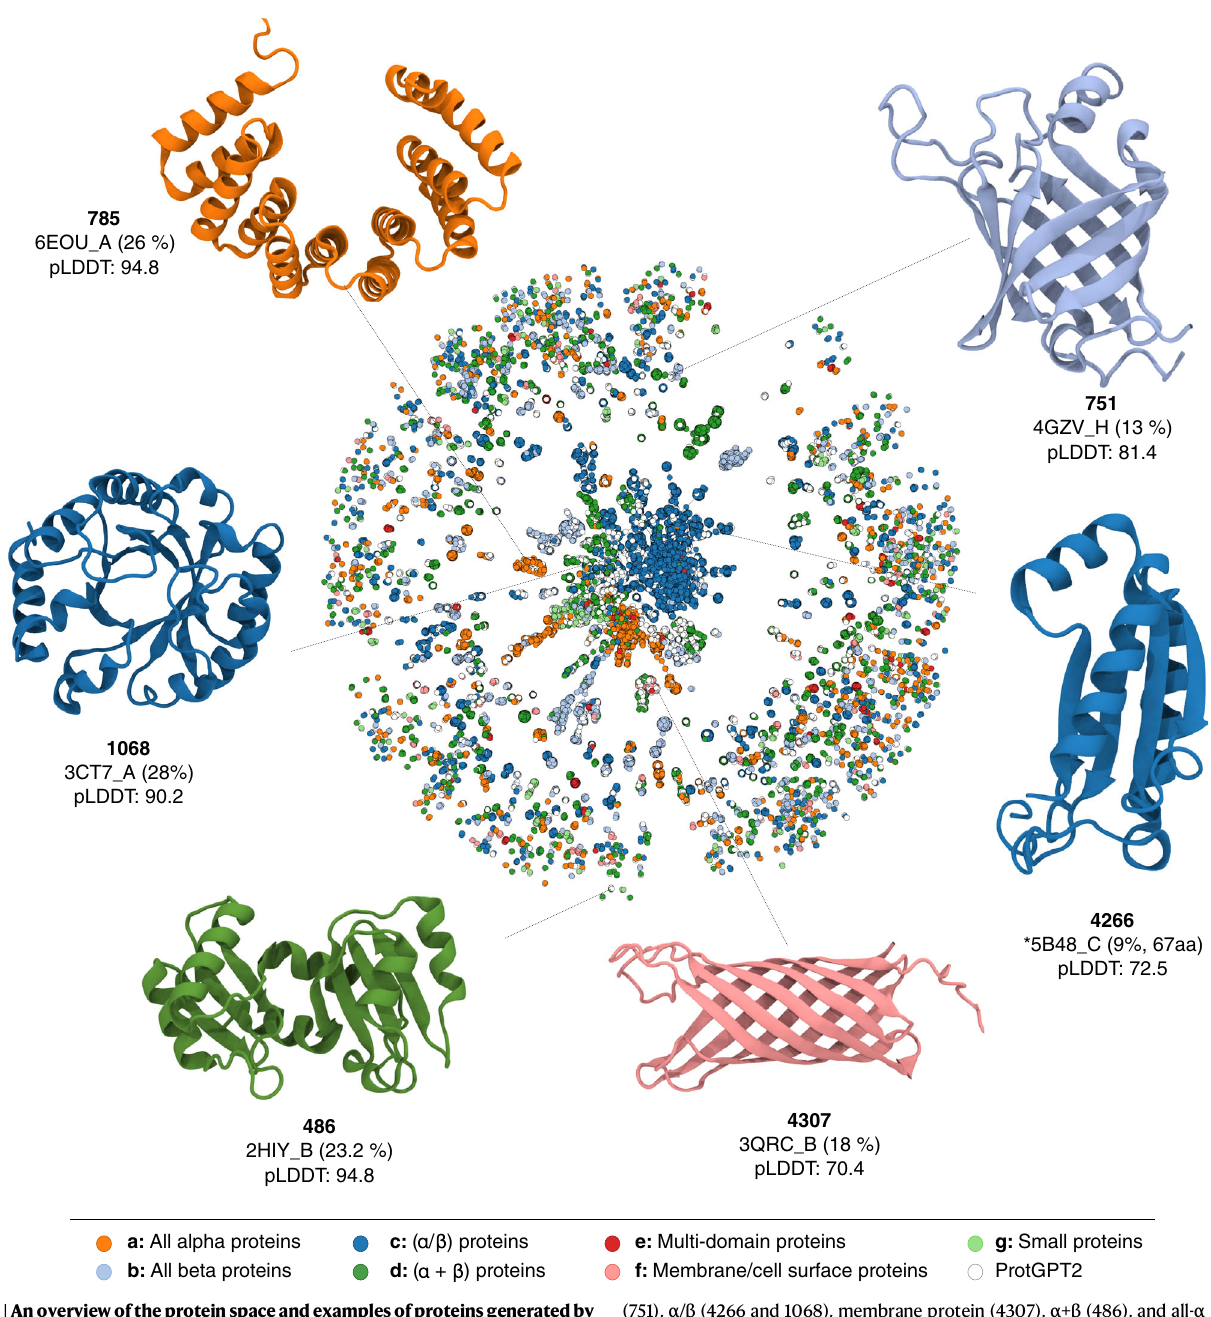
Fig.4|Anoverviewoftheproteinspaceandexamplesofproteinsgeneratedby ProtGPT2. Eachnoderepresentsasequence.Twonodesarelinkedwhentheyhave an alignment of at least 20 amino acids and 70% HHsearch probability. Colors depictthedifferentSCOPeclasses,andProtGPT2sequencesareshowninwhite.As examples,weselectproteinsofeachofthemajor fi veSCOPclasses:all- β